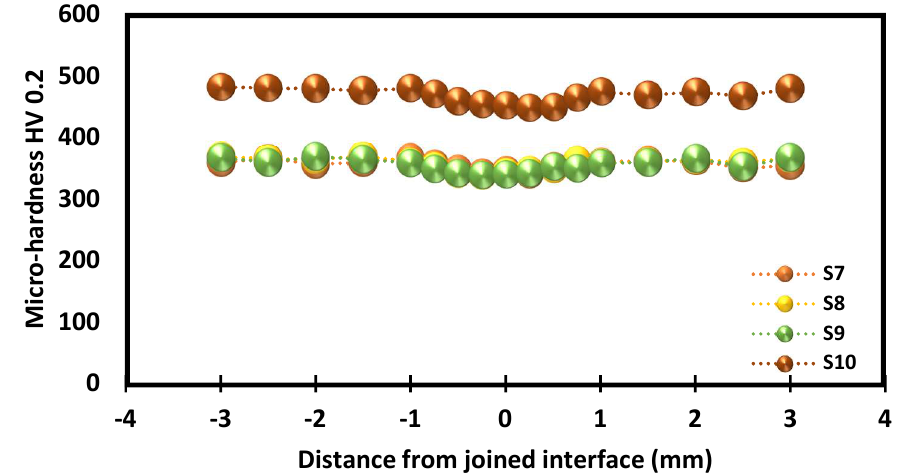
Figure 15. Hardness distributions of D2–D2 tool steel thixowelded joints at various conditions: ( S7 ) 1300 °C/0 min, ( S8 ) 1300 °C/5 min, ( S9 ) 1300 °C/10 min, ( S10 ) 1300 °C/10 min + post welding heat treatment.